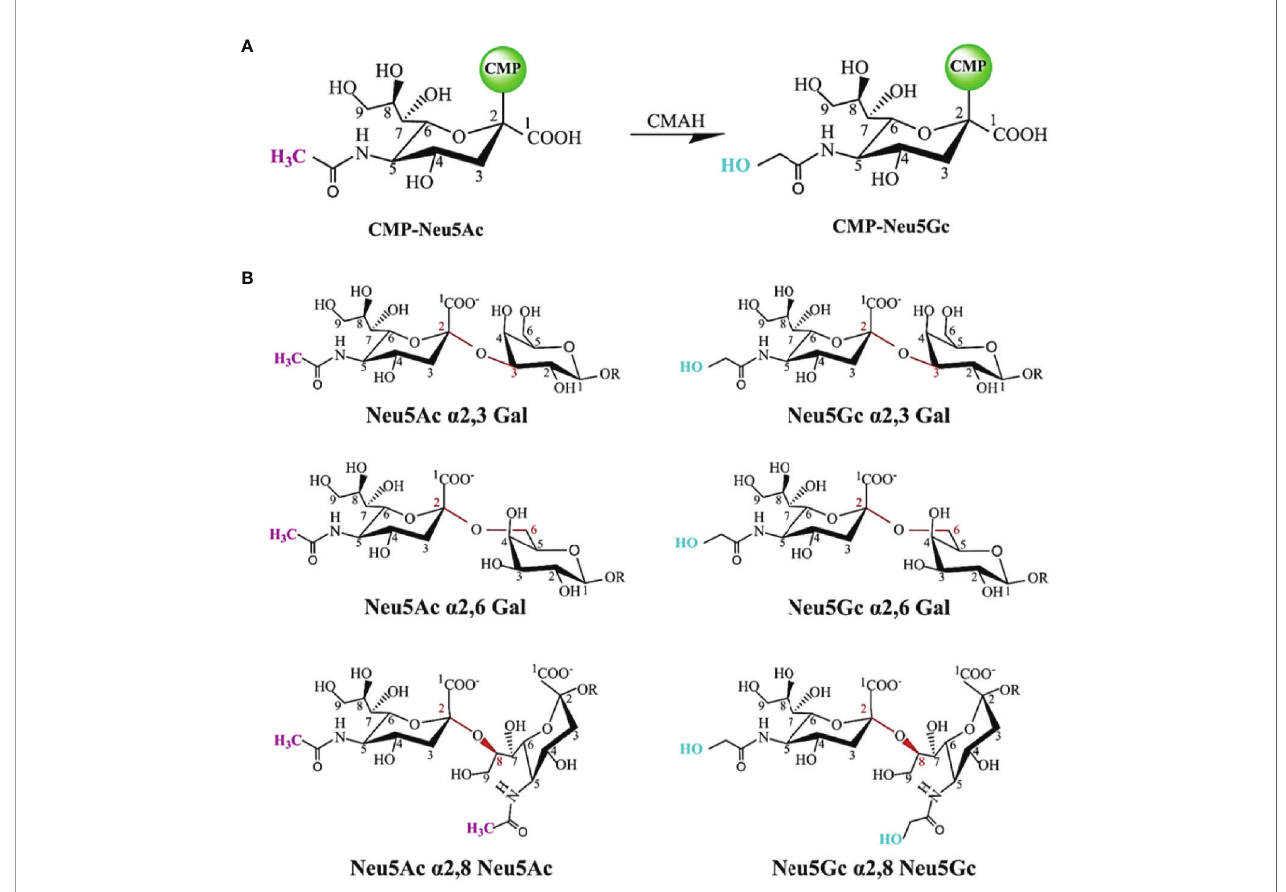
FIGURE 3 | Chemical structure of sialic acid (SA) and glycosidic linkage types. (A) Neu5Ac and Neu5Gc are the most common two SAs. The C5 carbon is modi fi ed with an N -acetyl group to form Neu5Ac. CMP-Neu5Ac can be hydroxylated to CMP-Neu5Gc, catalyzed by cytidine monophosphate N -acetylneuraminic acid hydroxylase (CMAH). Most mammalian tissues contain both SAs. In contrast, this enzyme is inactive and Neu5Gc is not expressed in normal human tissues. (B) SAs attached to the terminal positions of N -glycans or O -glycans of glycoproteins and glycolipids via different glycosidic linkages as viral receptors. SA can be linked through an a 2,3-linkage or an a 2,6-linkage to a penultimate galactose residue; through an a 2,6-linkage to N -acetylgalactosamine (GalNAc) moiety, and an a 2,8- linkage to another SA moiety on a